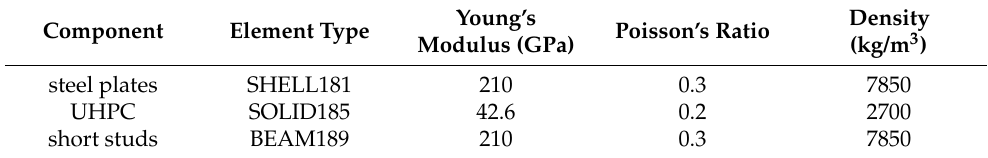
Table 1. Key parameters of the